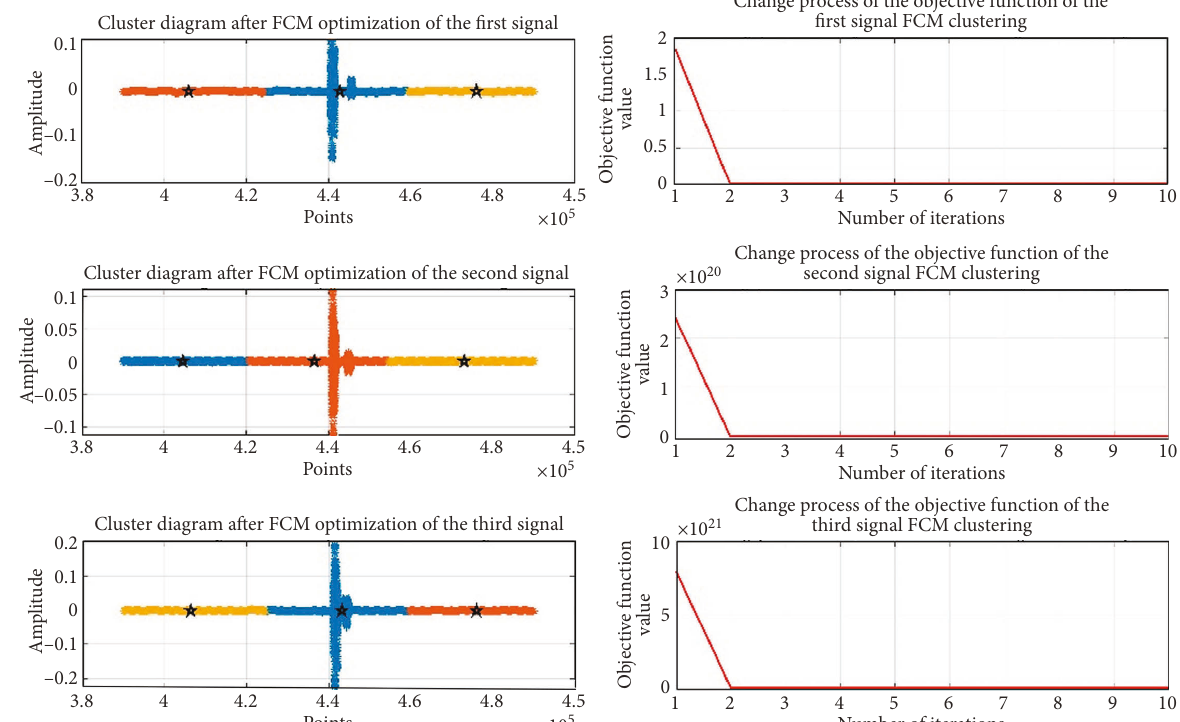
Figure 26: The cluster diagram and objective function change process after three-channel signal FCM optimization.